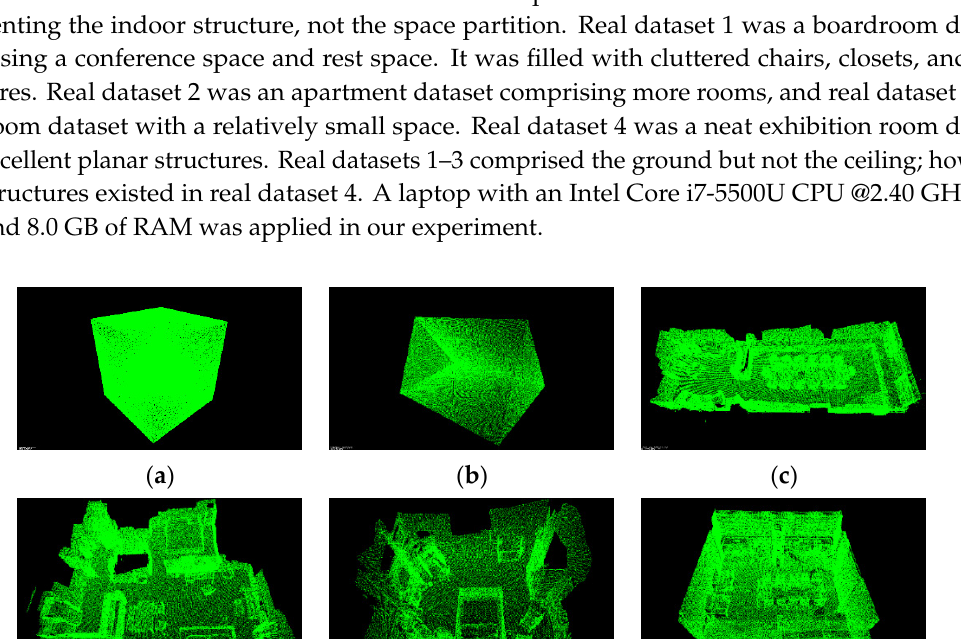
Figure 18. Parameter setting description: ( a ) region growing neighborhood, ( b ) (cid:2012) (cid:2869) , and ( c ) (cid:2012) (cid:2870) . (cid:2012) (cid:2869) (cid:3406) (cid:1828)(cid:1829) = (cid:1870) ∗ (cid:1863) ∗ (cid:2016) (cid:2869) (15) (cid:2012) (cid:2870) (cid:3406) 2√3 (cid:1870) ∗ (cid:2016) (cid:2869)